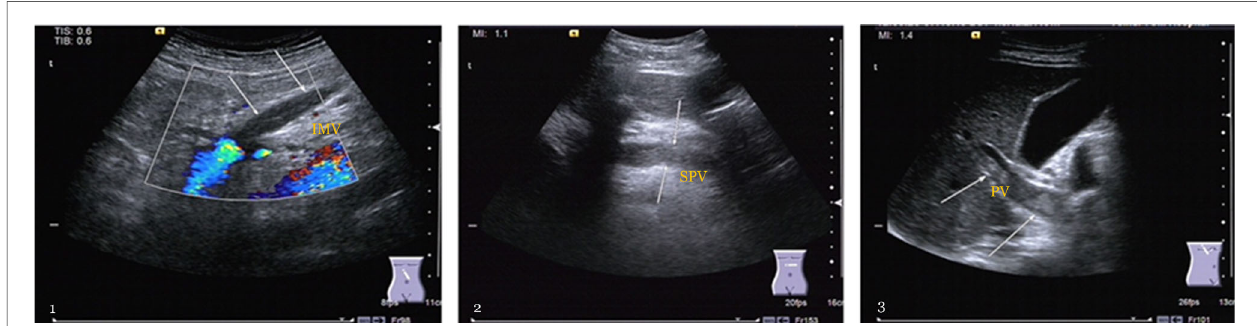
FIGURE 2 | The formation incident of portal vein system thrombosis. 1. Mesenteric vein thrombosis (MVT): gray-scale b-ultrasound image reveals hypoechoic thrombosis within the lumen, and color Doppler ultrasound shows a fi lling defect in the inferior mesenteric vein (IMV) (arrows). 2. Splenic vein thrombosis: the gray-scale b-ultrasound image shows that splenic vein (SPV) behind the pancreas were fi lled with hypoechoic thrombus (arrows), and the lumen was blocked. 3. Portal vein thrombosis (PVT): the gray-scale b-ultrasound image demonstrates that the primary portal vein (PV) is closely full of hypoechoic thrombus (arrows), and the main portal vein is almost completely